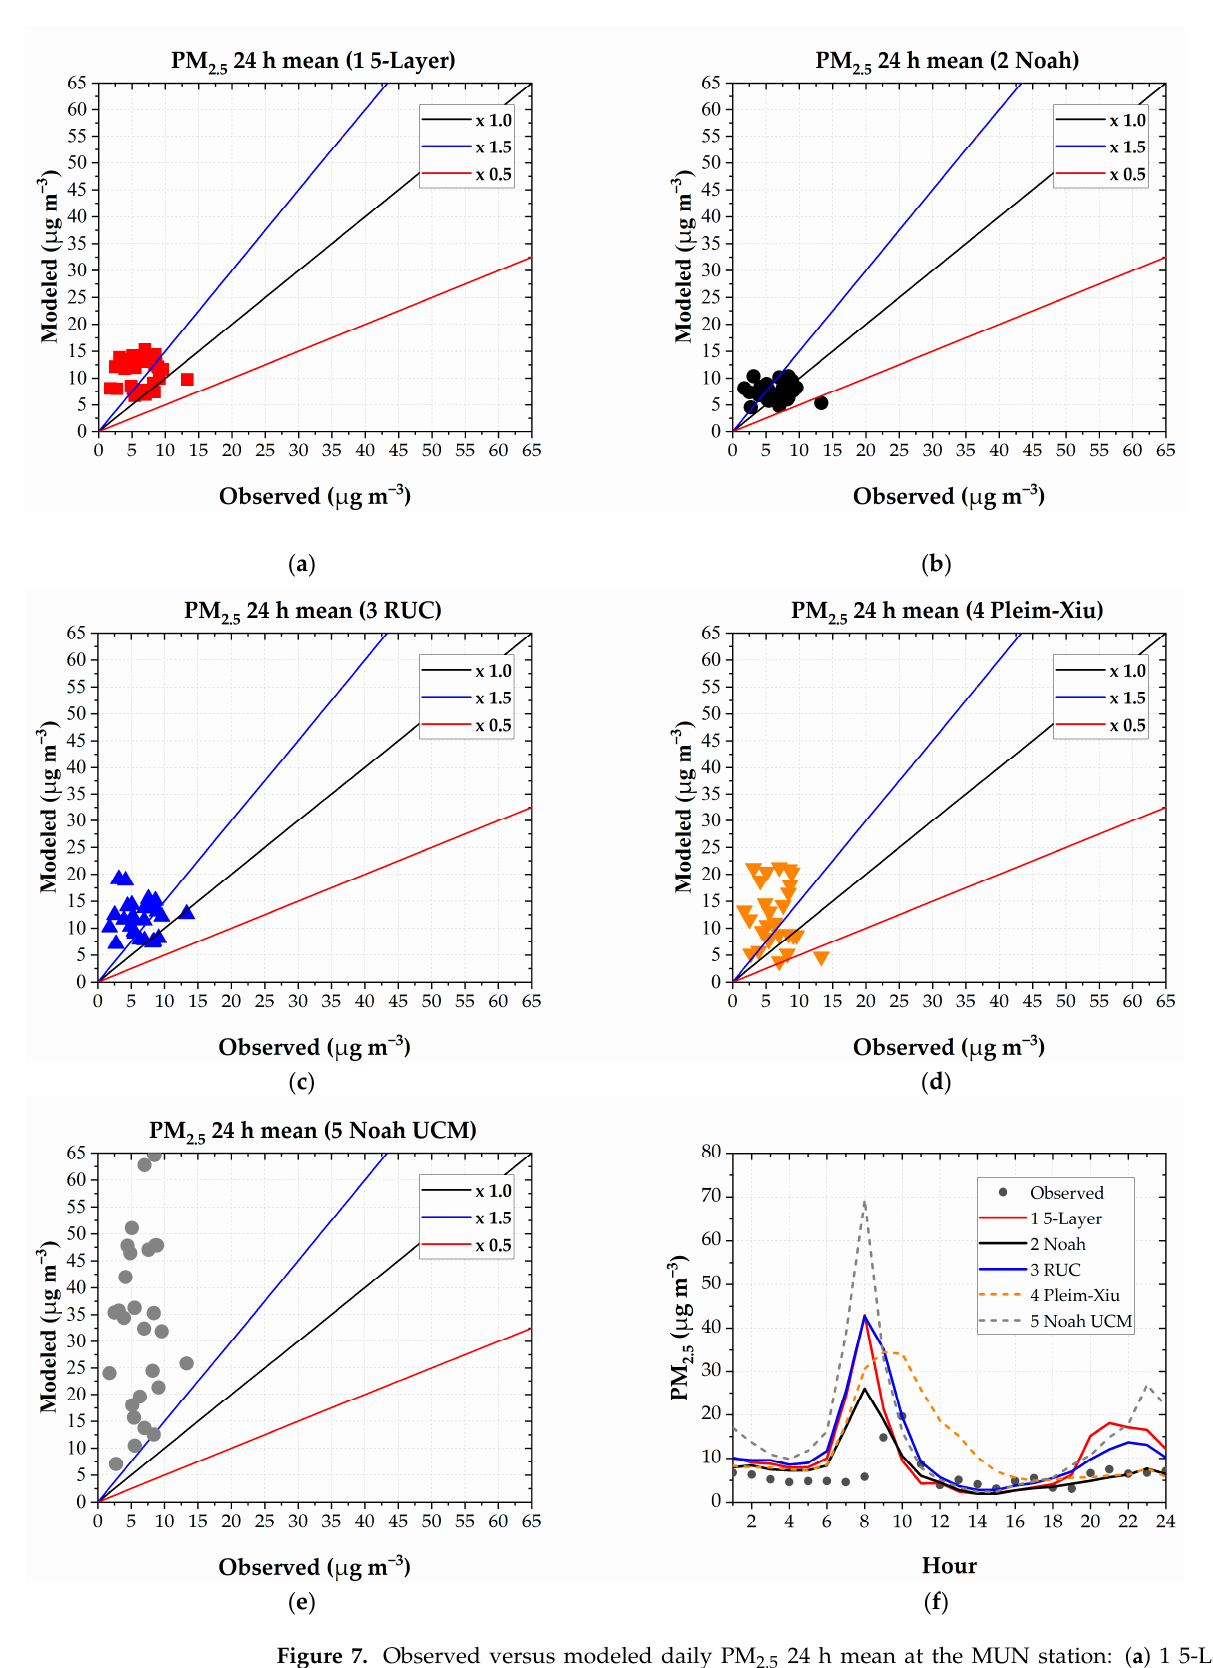
Figure 7. Observed versus modeled daily PM 2.5 24 h mean at the MUN station: ( a ) 1 5-Layer; ( b ) 2 Noah; ( c ) 3 RUC; ( d ) Pleim–Xiu; ( e ) 5 Noah UCM. ( f ) The mean daily profile of hourly PM 2.5 concentrations.